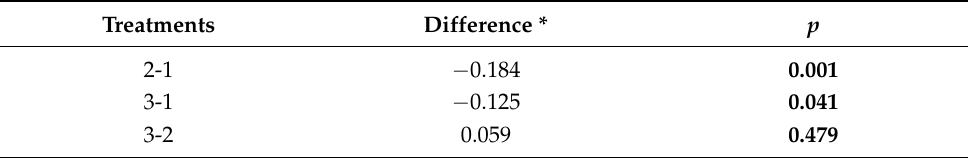
Table 3. Tukey HSD post hoc test results for relative residual adhesive volume. Treatments